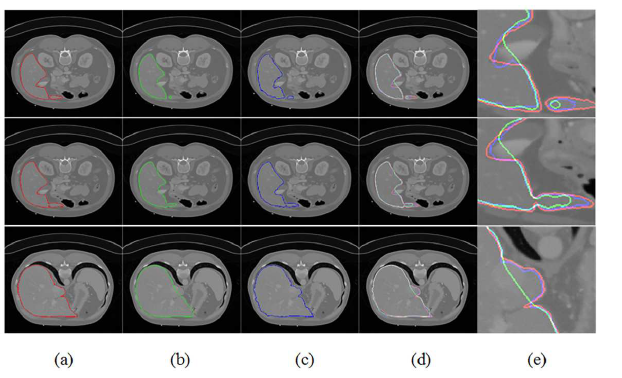
Fig 7. Comparison of results between the gold standard (red curves), RW (green curves)and FLRW (blue curves).